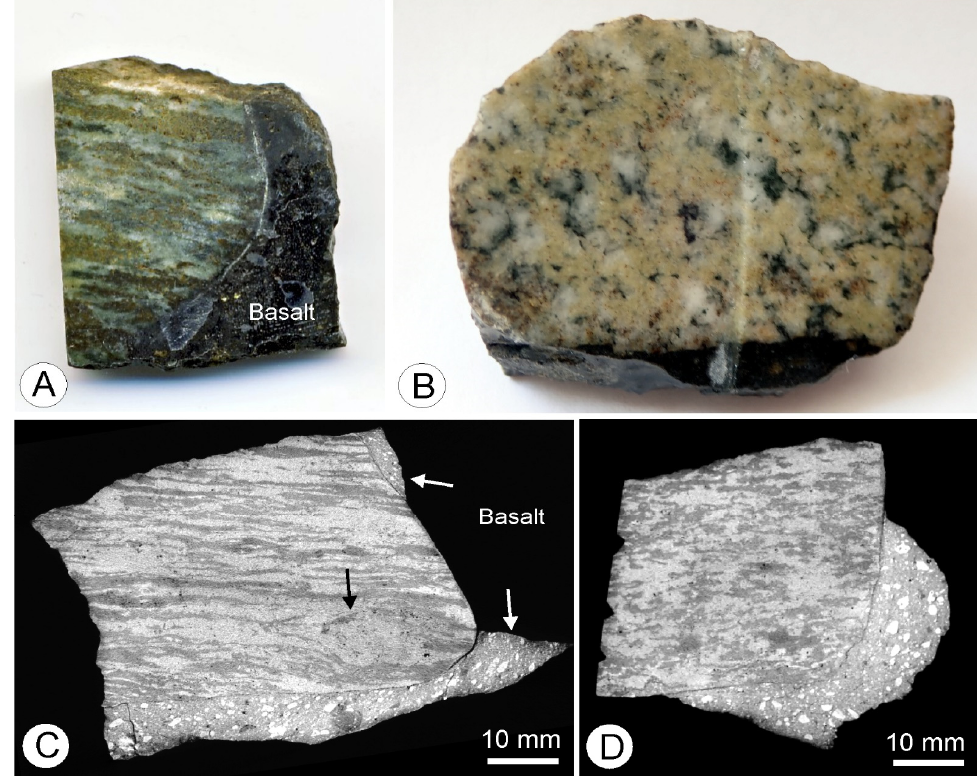
Figure 2. Skarnoid xenoliths in basalt from Č amovce quarry: ( A ) Banded texture of xenolith Ca ‐ 14, approximately 7 cm in size before cutting. Yellow ‐ green bands are composed of olivine and pyroxene; ( B ) Granular texture in the section perpendicular to layering (sample Cam ‐ 13). Yellow parts correspond to olivine, dark green grains are pyroxenes and white areas are plagioclases. The xenolith is 5 cm in diameter; ( C , D ) Two differently oriented CT scans of xenolith Ca ‐ 14, showing banded, spindle ‐ like texture in the longitudinal and speckled texture in the perpendicular section. Bright isolated grains in basalt correspond to olivine phenocrysts. Darker areas in xenoliths represent plagioclases, whereas brighter ones are mafic minerals, mainly pyroxene and olivine. Solid arrow in ( C ) designates the pod of mafic minerals.